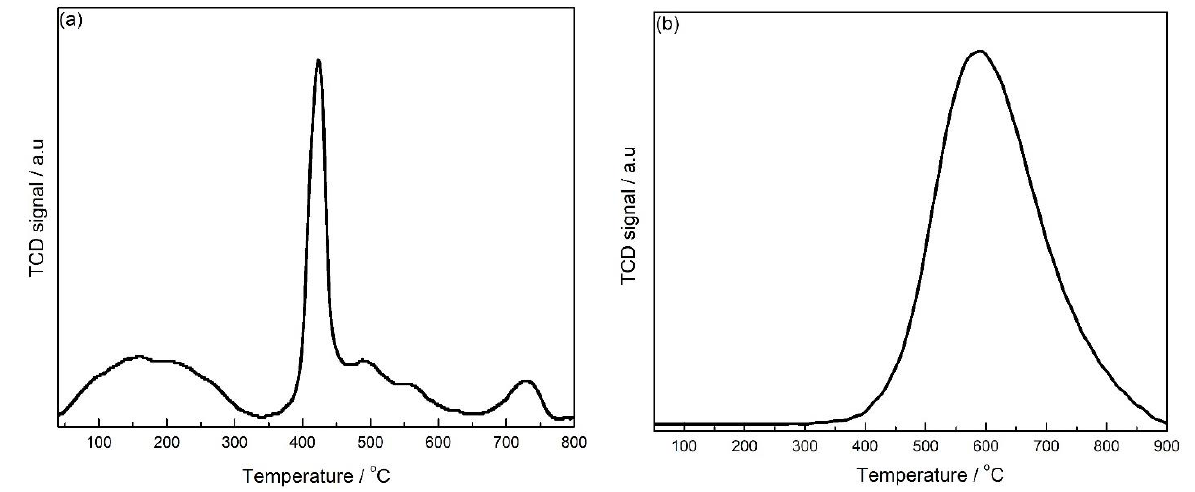
Figure 3. ( a ) CO 2 -TPD; ( b ) H 2 -TPR of CoNi@C.